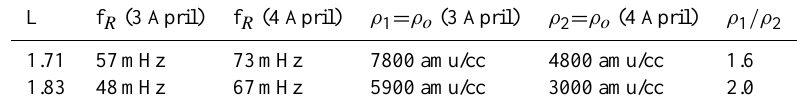
Table 2. Resonant frequencies and corresponding equatorial densities.